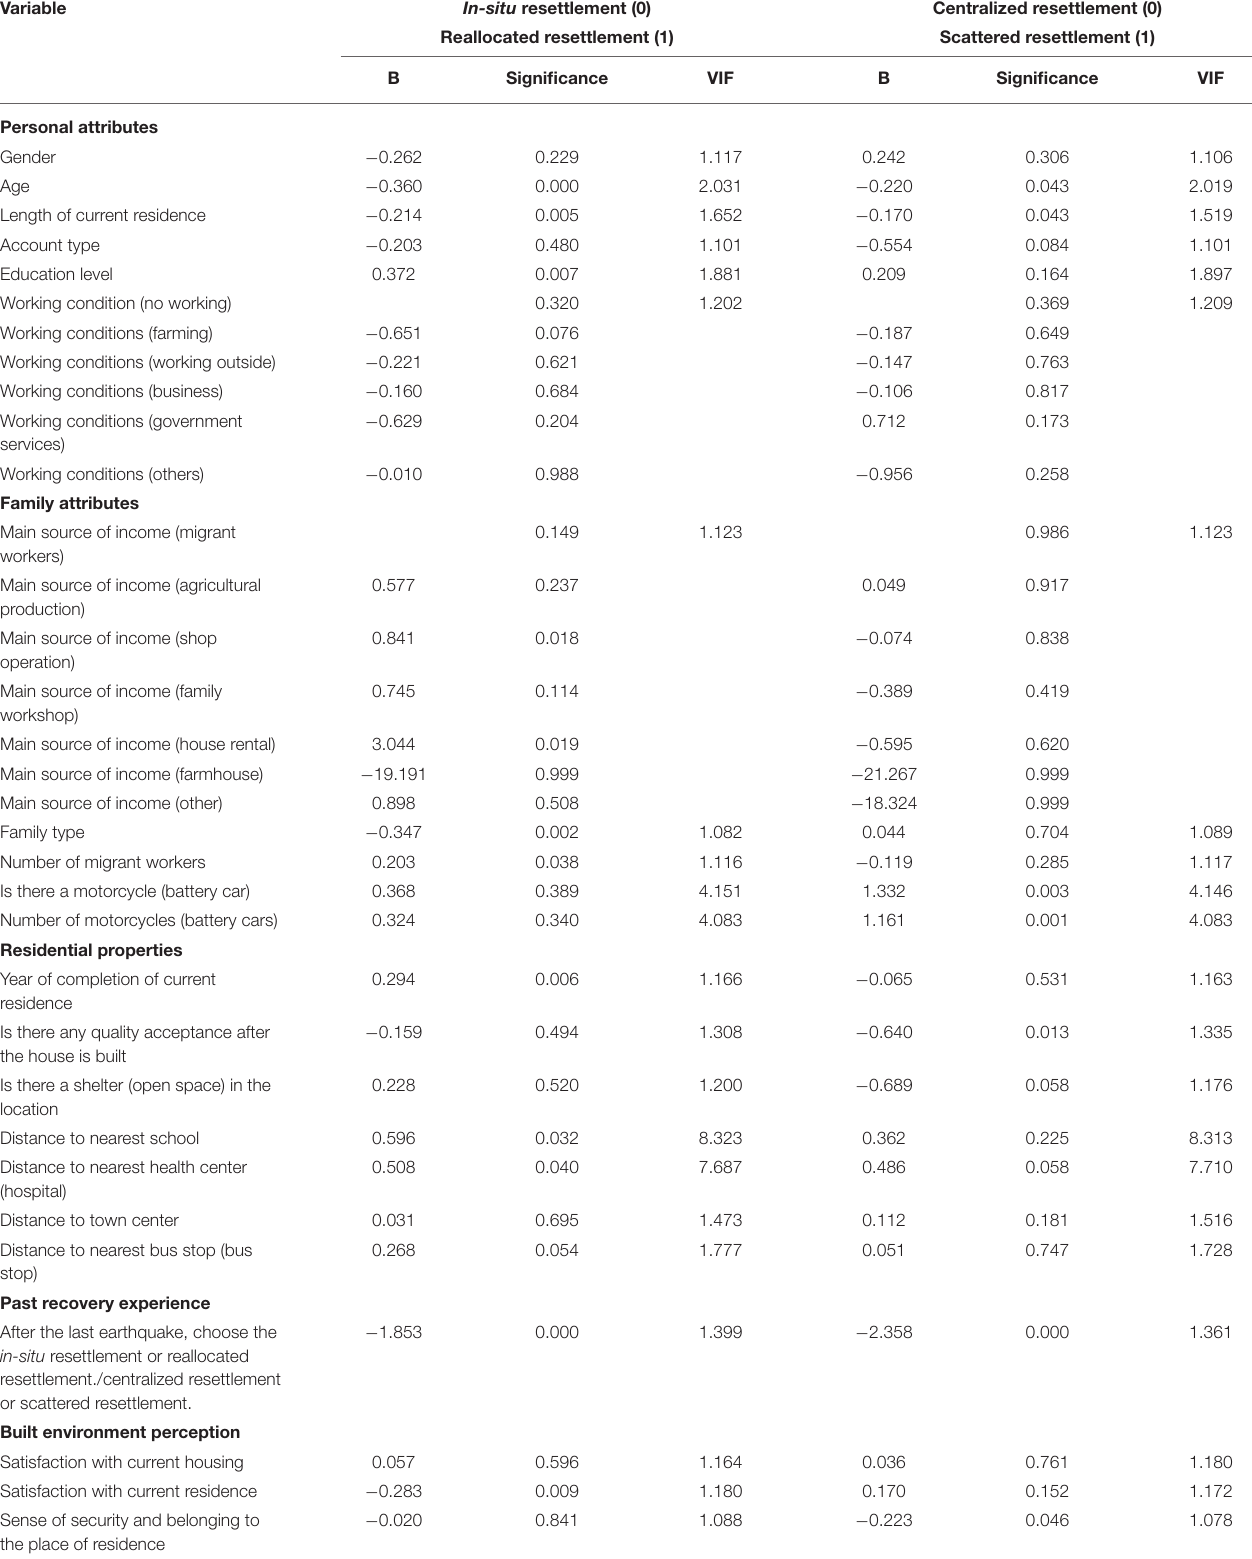
TABLE 7 | Results of binary logistic regression